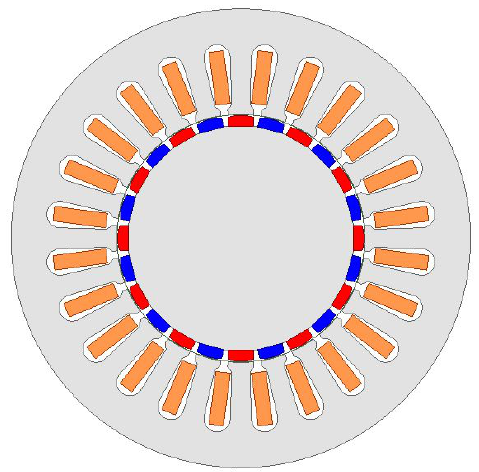
Figure 8. Cogging motor configuration with 12 pole pairs .